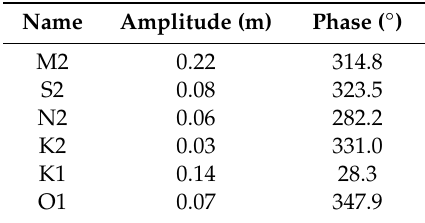
Table 1. Main astronomical constituents for the tidal regime in Callao Bay extracted from TPXO 7.2